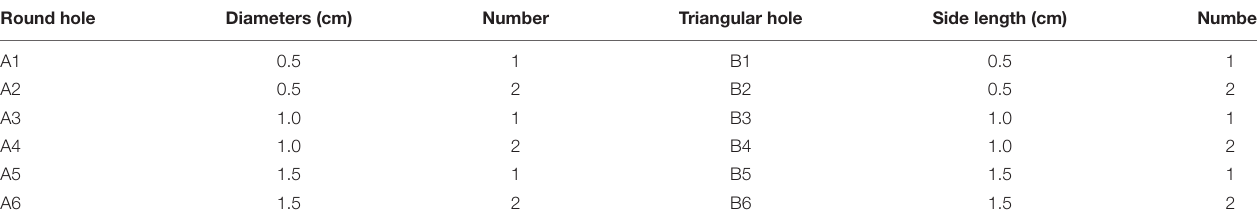
TABLE 1 | Punch round holes and triangular holes in the fixed position of the bag. Round hole Diameters (cm) Number Triangular